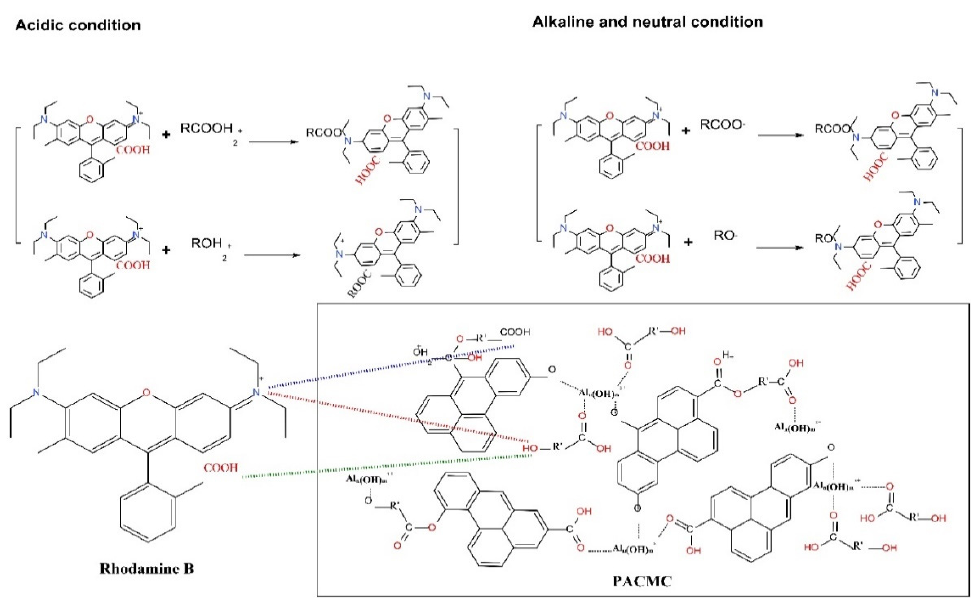
Figure 11. Possible mechanism of RhB adsorption by PACMC.